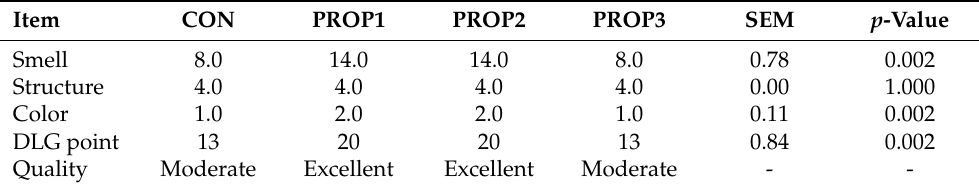
Table 2. The effects of different propolis levels on silage qualities (n =